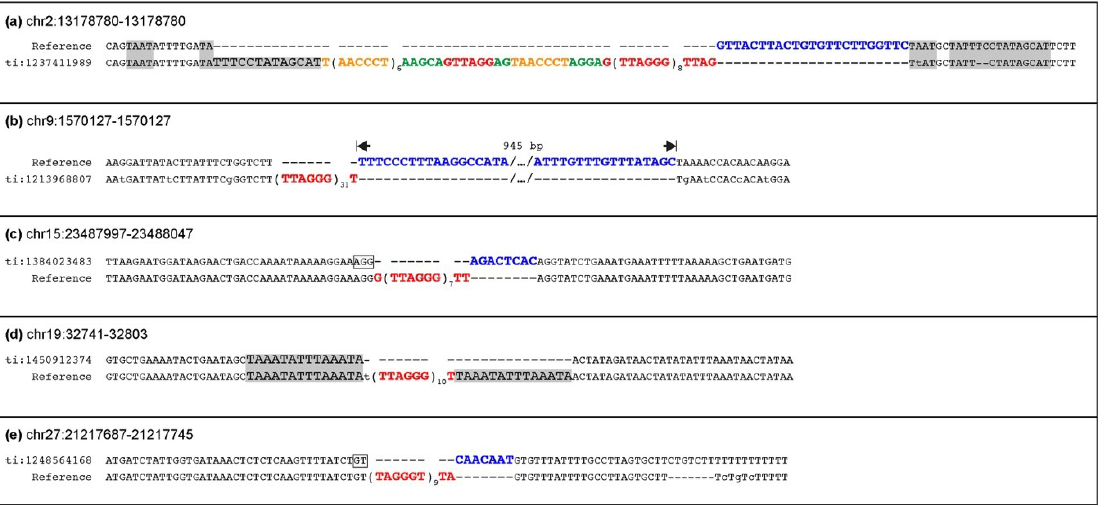
Figure 2. ITS loci heterozygous in Twilight. For each locus, sequence alignment of the empty allele (top) with the ITS-containing allele (bottom) is shown. The sequence indicated as Reference corresponds to the allele found in the horse reference genome EquCab3.0, the alternative allele is indicated by the NCBI Trace ID number. Telomeric repeats in TTAGGG and CCCTAA orientation are indicated in red and orange, respectively. Flanking sequence modifications that occurred together with telomeric repeat insertions are indicated using different colors: nucleotides deleted from the flanking sequence are in blue; random nucleotides sequence insertions are in green; duplications of the insertion site are shaded in grey. Nucleotides at break sites in register with the inserted telomeric repeats are boxed.